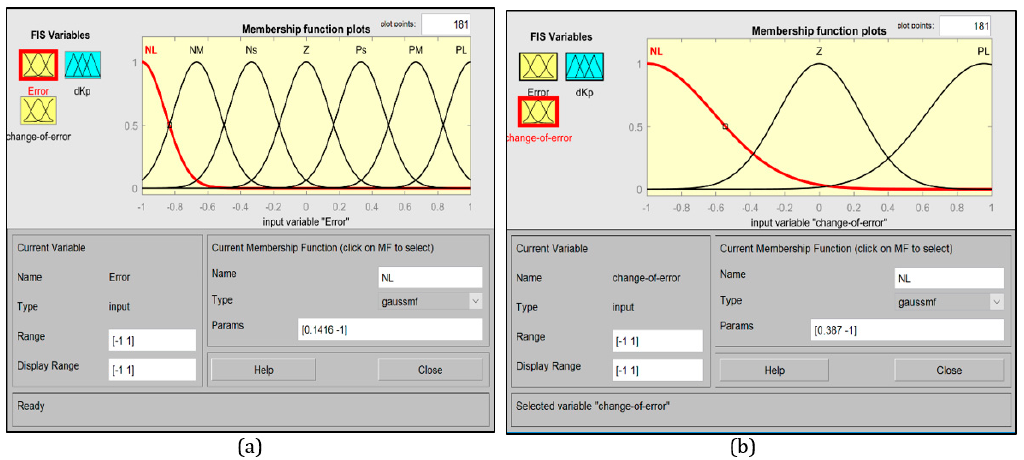
Figure 5. Membership functions. (a) e H , e V ,dKp, (b) de H , de V.